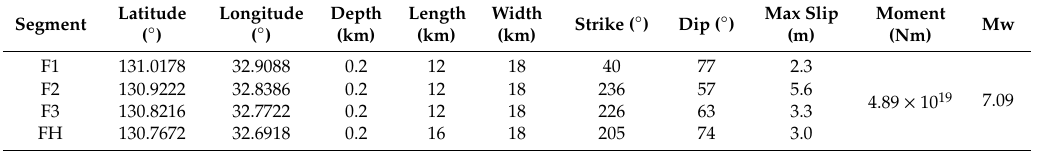
Figure 4. Comparison of the estimations of fault dip angles with the jRi and root mean square error (RMSE) methods. ( a ) Plot of the jRi values as a function of dip angles for four segments. ( b ) Plot of the RMSE values. Optimal dip angles corresponding to minimal jRi and RMSE values are marked with cross symbols. Table 2. Fault parameters of the four-segment fault model used in this